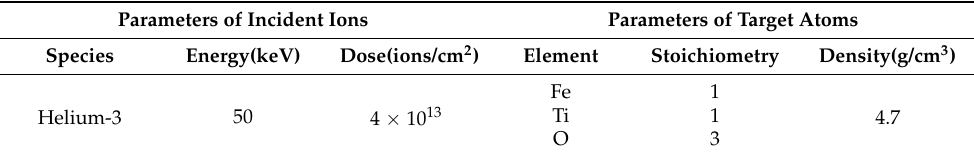
Table 1. Parameters required for SRIM (Stopping and Range of Ions in Matter) simulation of helium-3 implantation into ilmenite.